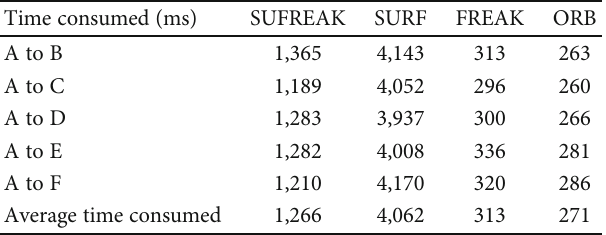
Table 2: Statistics of time consumption for image matching of each